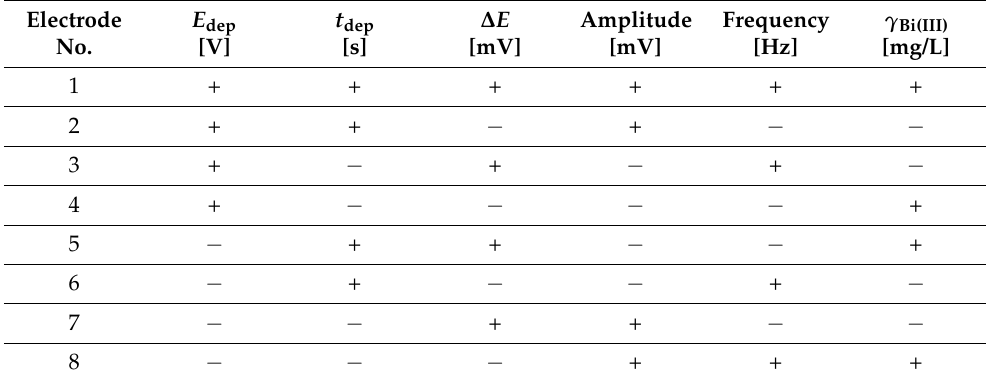
Table 2. Fractional two-level factorial design with six factors (+ stands for the factor when it is at the high level, and − stands for the factor when it is at the low